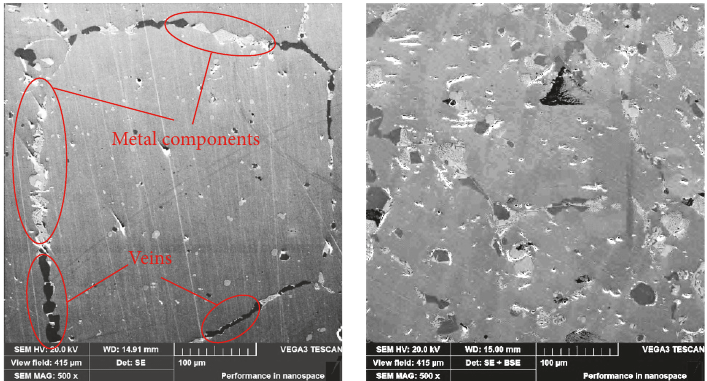
Figure 6: Microstructure of the corium material